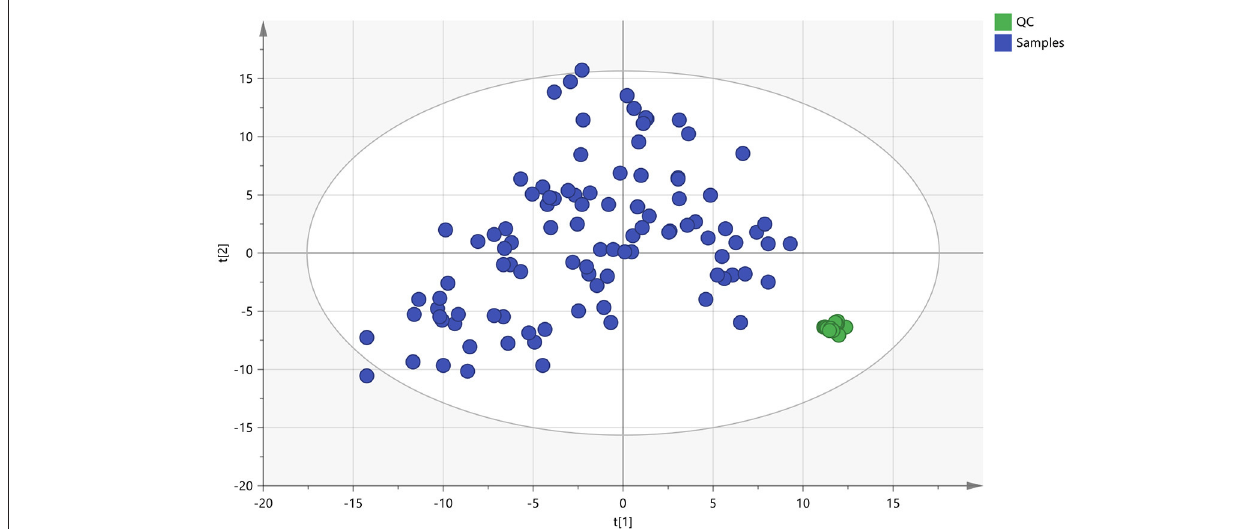
FIGURE 5 | The PCA scores plot of QC and On-test Samples. Quality control (QC) samples were applied to exhibit the stability of the liquid chromatography-mass spectrometer (LC-MS) system. The cluster of the quality control samples in the principal component analysis scores scatter plot showed a satisfactory stability and repeatability of this lipidomic analysis approach. The colors display the subjects from different groups. : QC, quality control; , Test samples.